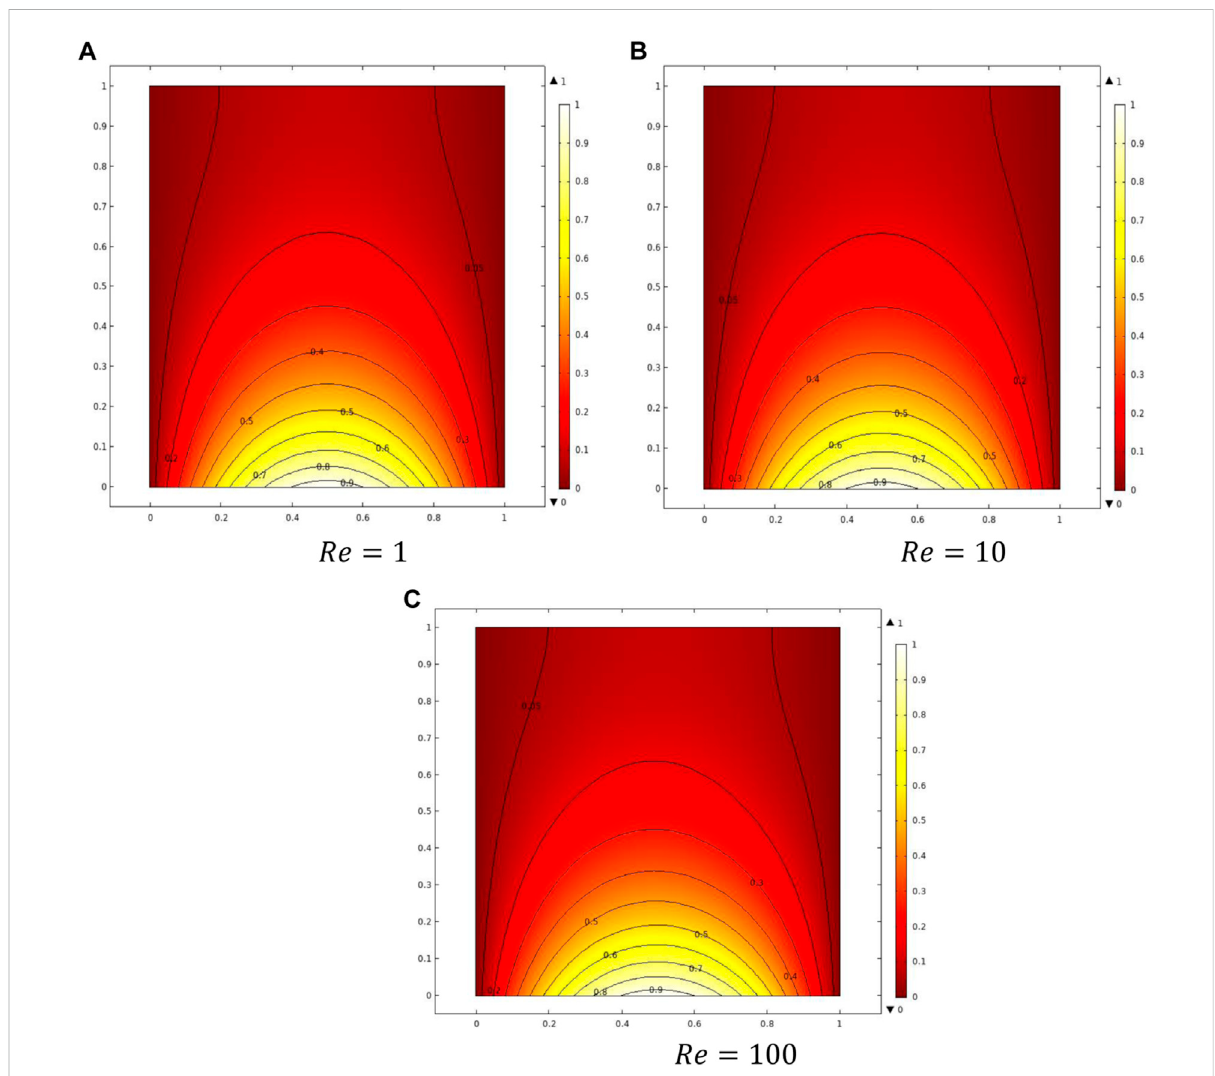
FIGURE 14 In fl uence of Re on the temperature pro fi le for the non-uniform heating case. (A) Re (cid:1) 1, (B) Re (cid:1) 10, (C) Re (cid:1)